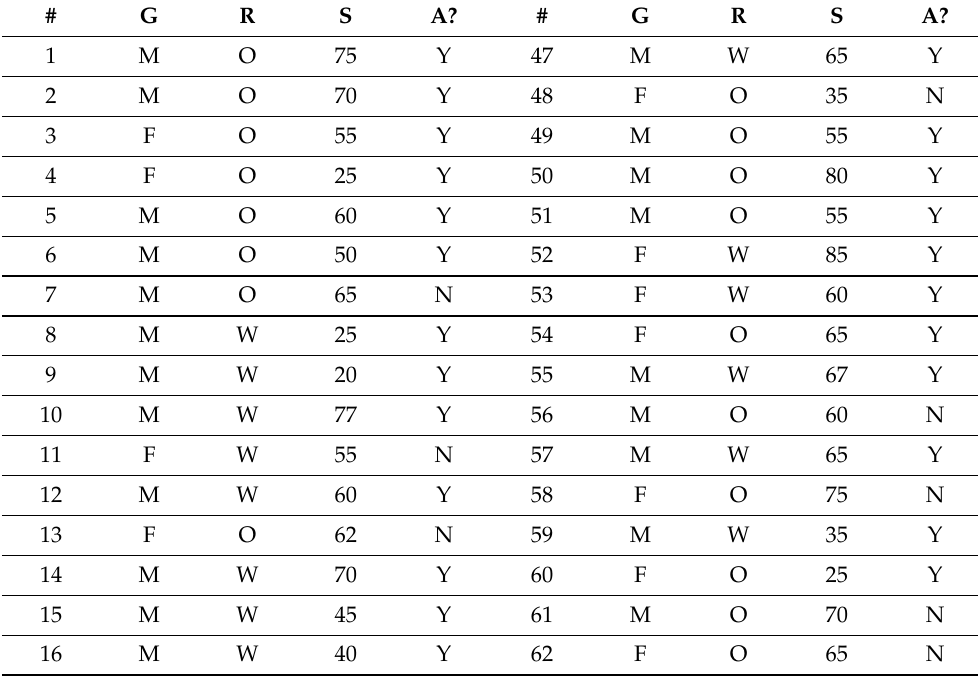
Table 1. Row data for the